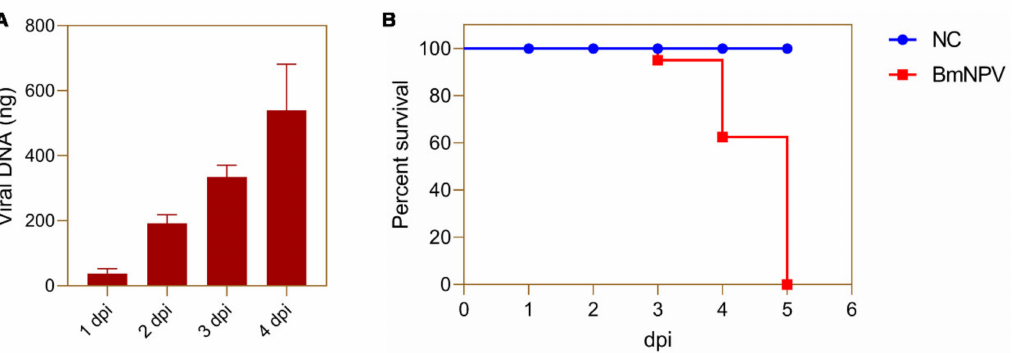
Figure 1. Time course of BmNPV replication and silkworm mortality. Newly molted fifth-instar silkworm larvae (Dazhao) were injected with either 10 µ L of BmNPV-EGFP (10 4.8 TCID50) or PBS. ( A ) Hemocytes were collected for absolute quantification of viral DNA at 1, 2, 3, and 4 d. ( B ) The survival curve of silkworm larvae after injection of BmNPV or PBS for 1–5